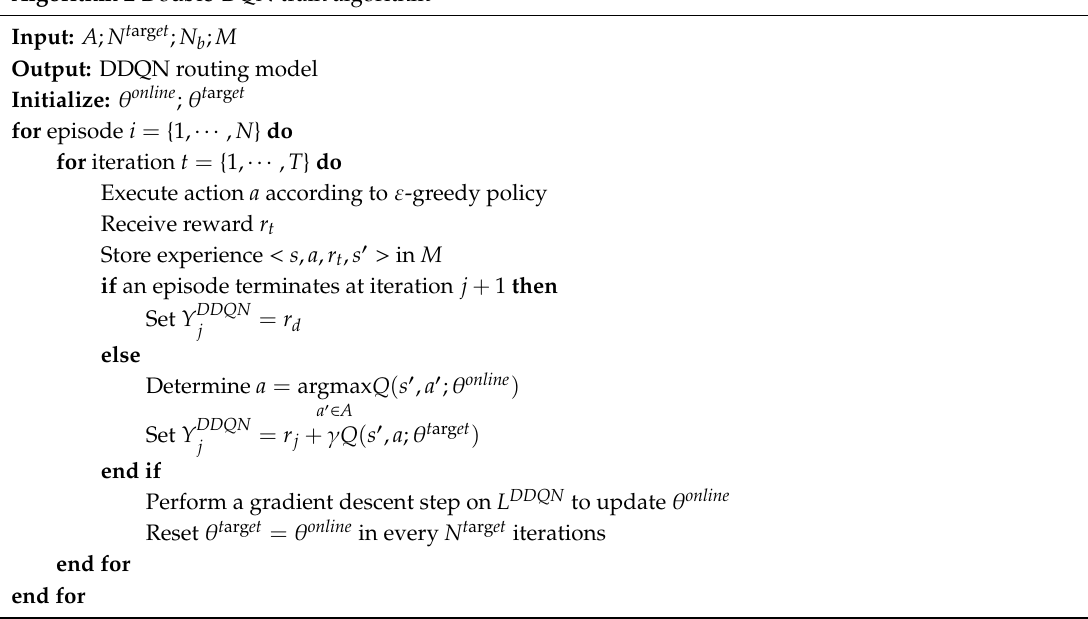
Algorithm 2 Double-DQN train